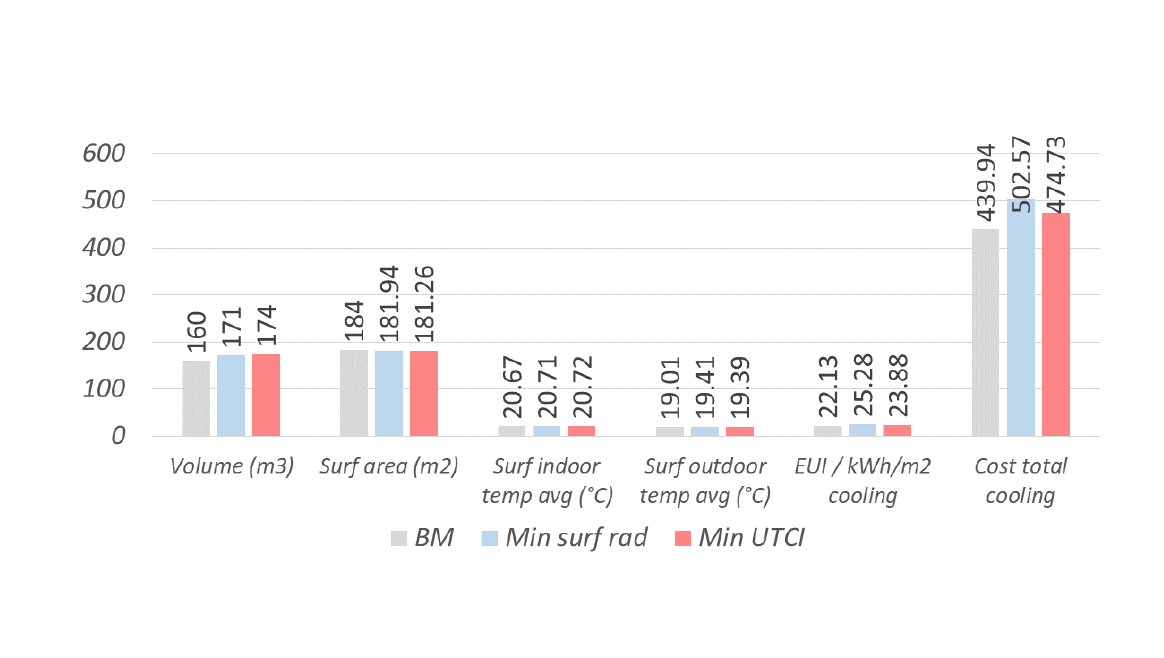
¥ 31 with the minimum radiation model and about ¥ 16 with the minimum UTCI model. It is indicated that